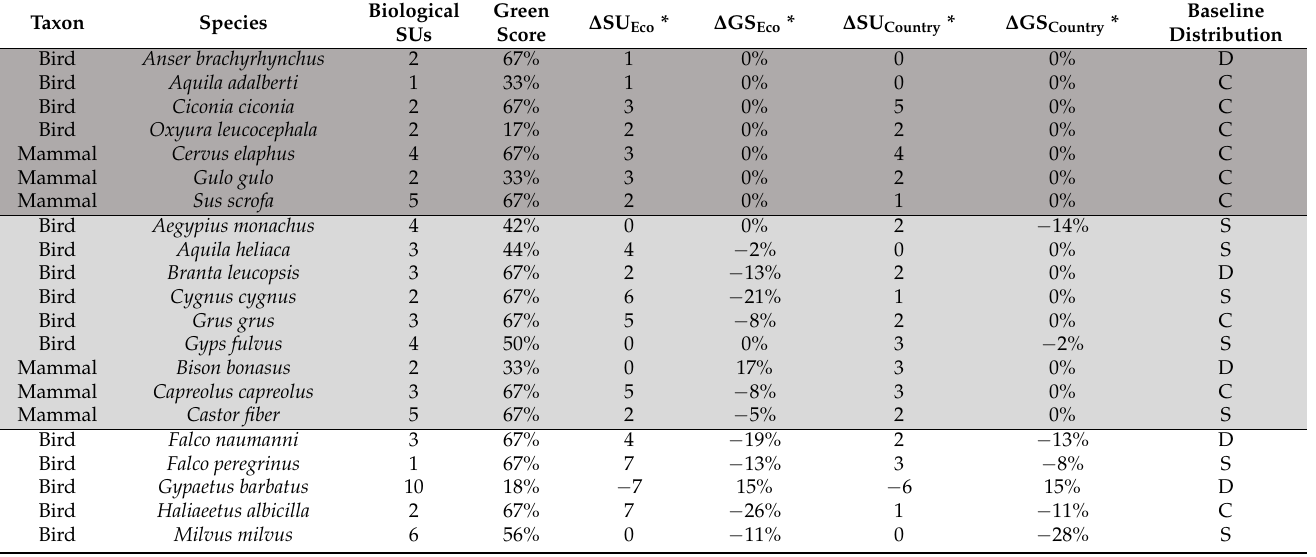
Table 1. Species results, compared against biological spatial units (SUs). Number of spatial units and Green Scores generated using ecologically based and country-based methods are shown as differences ( ∆ ) from biological results. For context, the baseline distribution is characterized as continuous (C), semi-continuous (S), or discontinuous (D). This table shows the highest-order delineation methods: ecological spatial units are based on biomes, and country-based spatial units include countries comprising ≥ 5% of the baseline distribution. Colored rows indicate species for which the same Green Score was obtained using the biological method and both other methods (dark gray) or one other (light gray). Note that these are not the results that would be generated using a full Green Status assessment (see Section 2) and should therefore not be referenced as the Green Status outputs for these species.